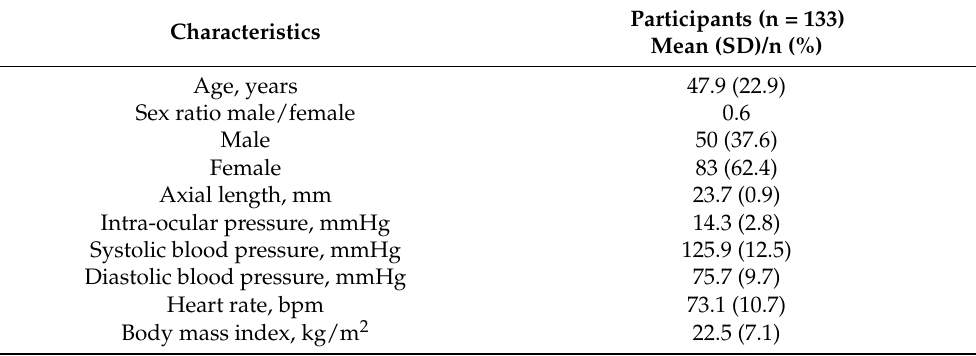
Table 1. Clinical characteristics of the study population.